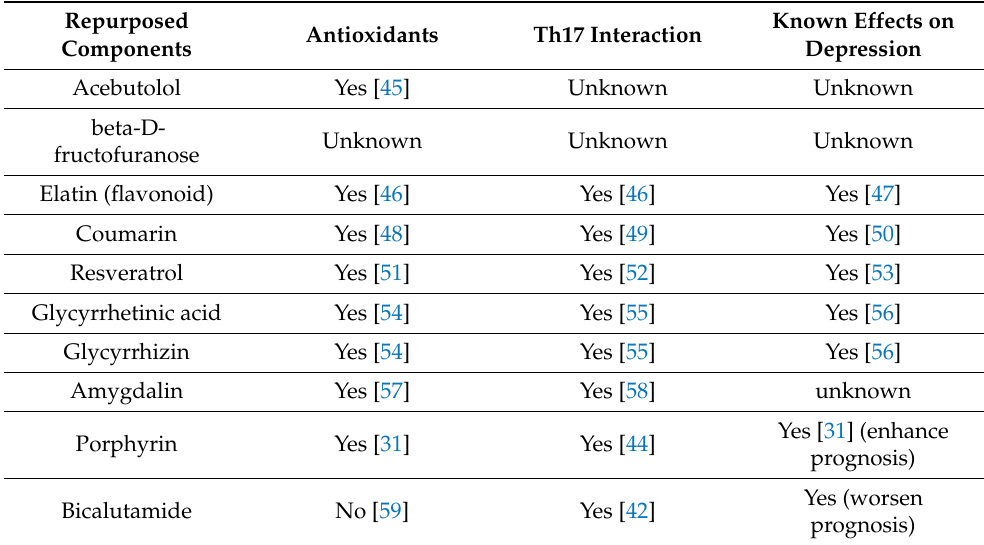
Figure 6. BBB infiltration predictions of bicalutamide. Table 7. Repurposed components arranged based on their